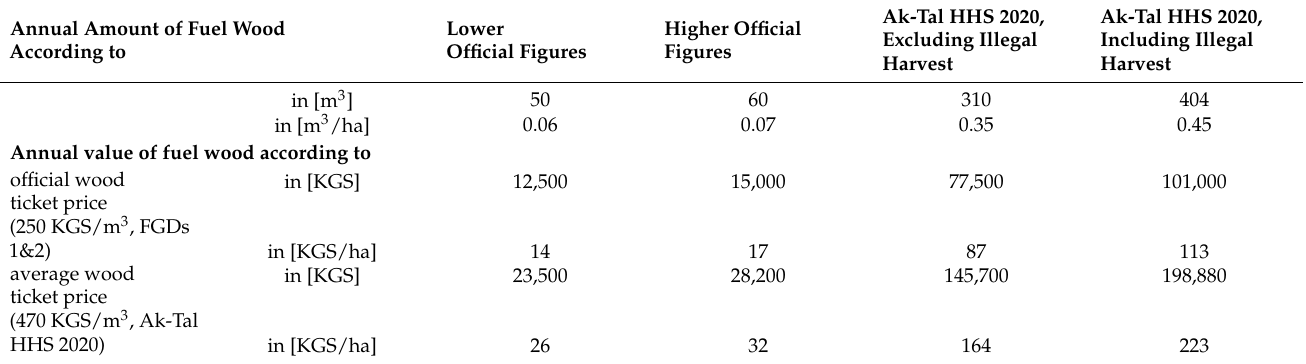
Table 2. Projected annual amount and value of the Ak-Tal Village fuel wood harvest according to different